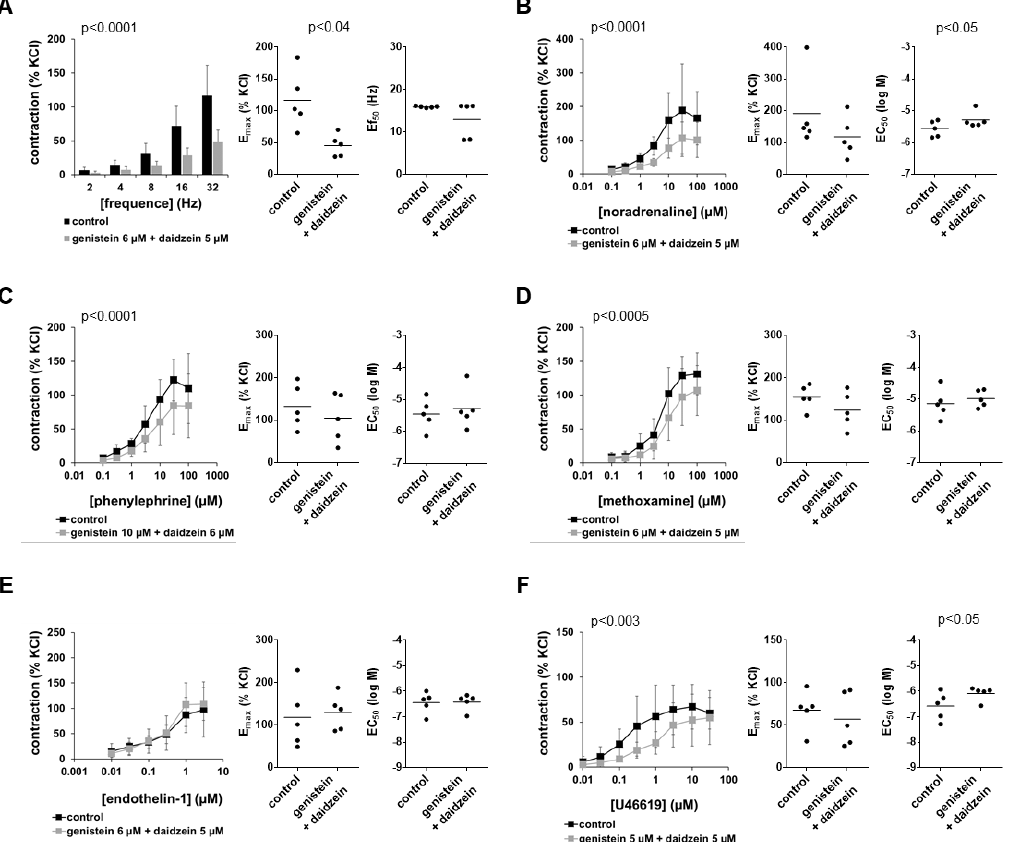
Figure 5. Effects of combined genistein and daidzein on EFS- and agonist-induced contractions of human prostate tissues. Contractions were induced by EFS ( A ), noradrenaline ( B ), phenylephrine ( C ), methoxamine ( D ), endothelin-1 ( E ) and U46619 ( F ) in the presence of 6 µM genistein plus 5 µM daidzein and corresponding amounts of solvent (DMSO) for the controls added 30 min before the construction of frequency and concentration–response curves. Data from experiments with tissues from n = 5 patients are shown in each diagram. In each experiment, tissue from one patient was allocated to the control and genistein + daidzein groups. Data are means ± SDs in frequency/concentration–response curves ( p -values for whole groups from two-way ANOVA), and E max , Ef 50 and EC 50 values are from all